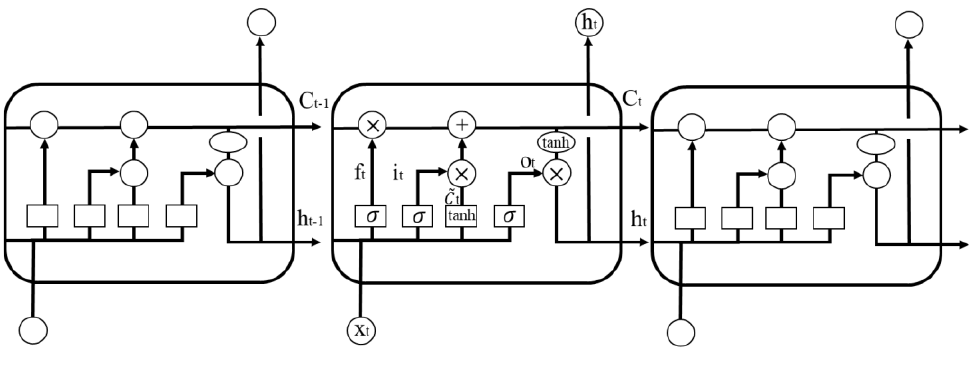
Figure 5. The structure of the LSTM